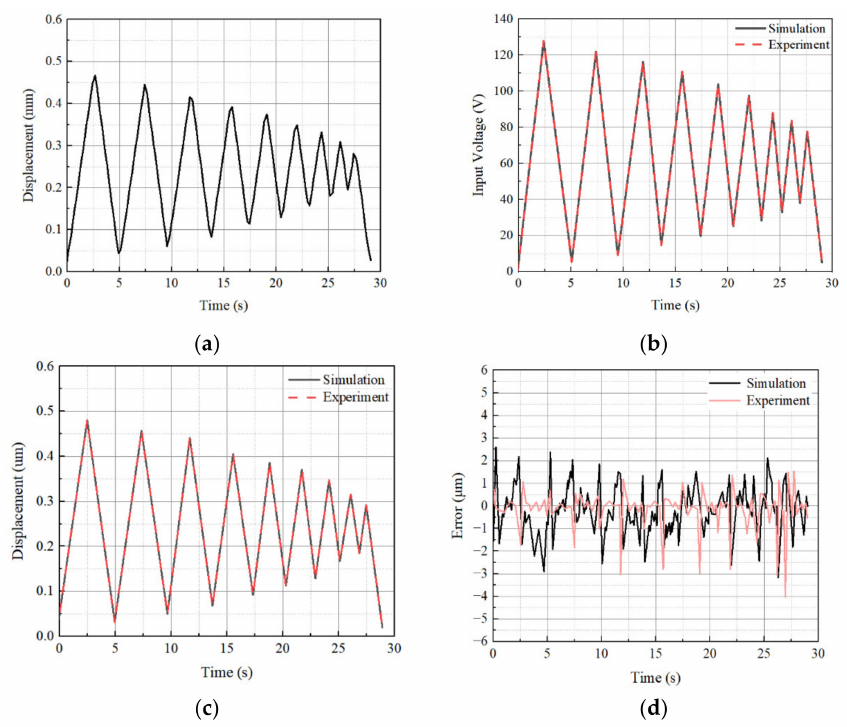
Figure 12. Tracking control results of the spool displacement with the triangular trajectory at 20 ◦